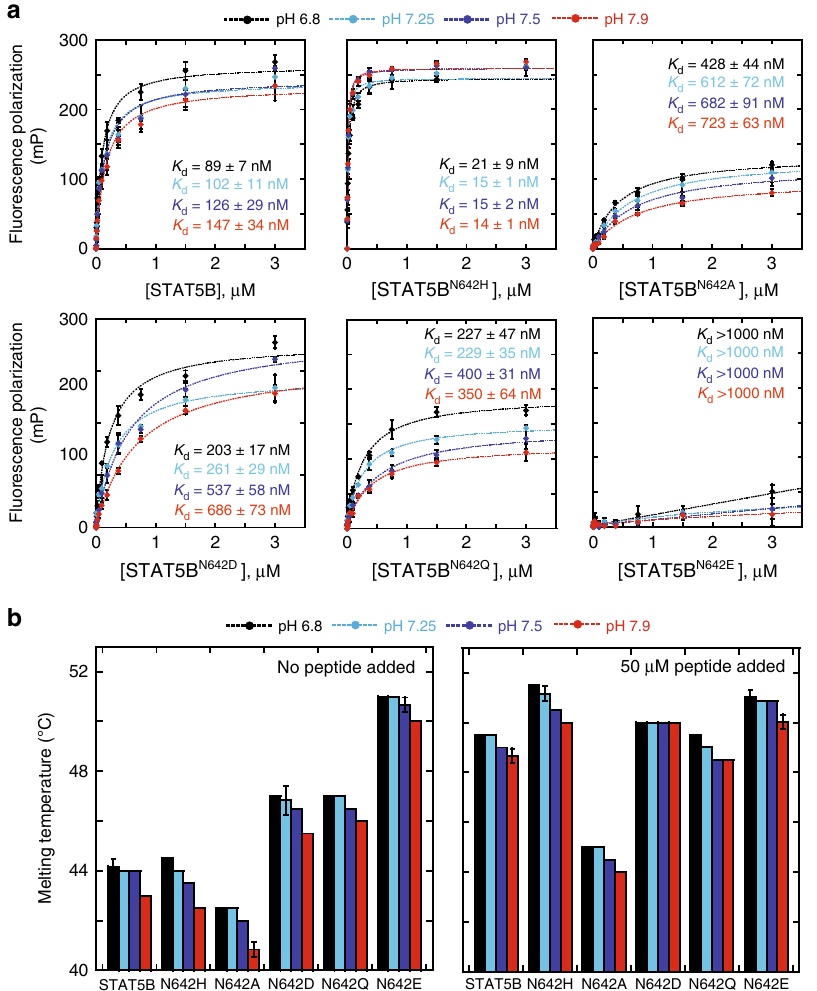
Fig. 6 FP binding assays and denaturation temperatures of STAT5B /STAT5B N642 mutants. a The fl uorescence polarization of 10 nM fl uorescently labeled peptide was measured from samples containing increasing concentrations of wild-type/mutant STAT5B and the dissociation constants were determined from curve- fi tting to a 1:1 protein-ligand model. The error bars show the mean ± SD from three independent titrations, and the K d is reported with the error in the fi t. b The denaturation temperatures of 2.5 µ M STAT5B and STAT5B N642 mutants were determined at different pH values in the presence or absence of 50 µ M peptide. The melting temperature is reported as the average from three independent samples and the error bars show the mean ± SD. Source data are provided as a Source Data fi